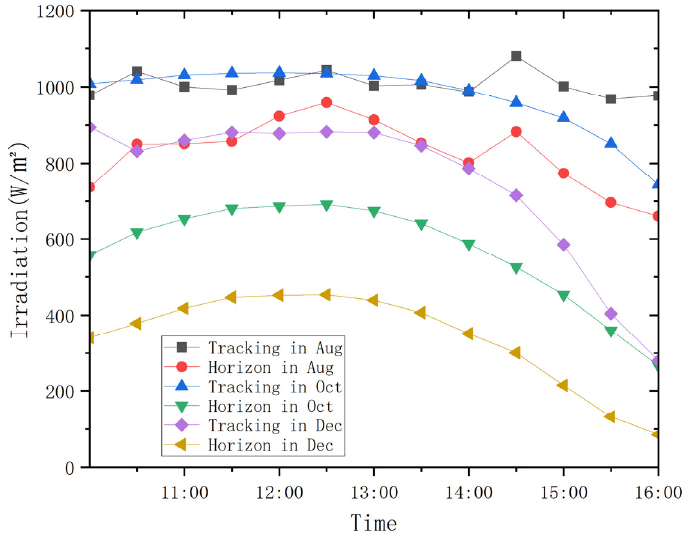
Figure 6. Electrothermal efficiency and exergy efficiency of LCPV/T-VMD system.